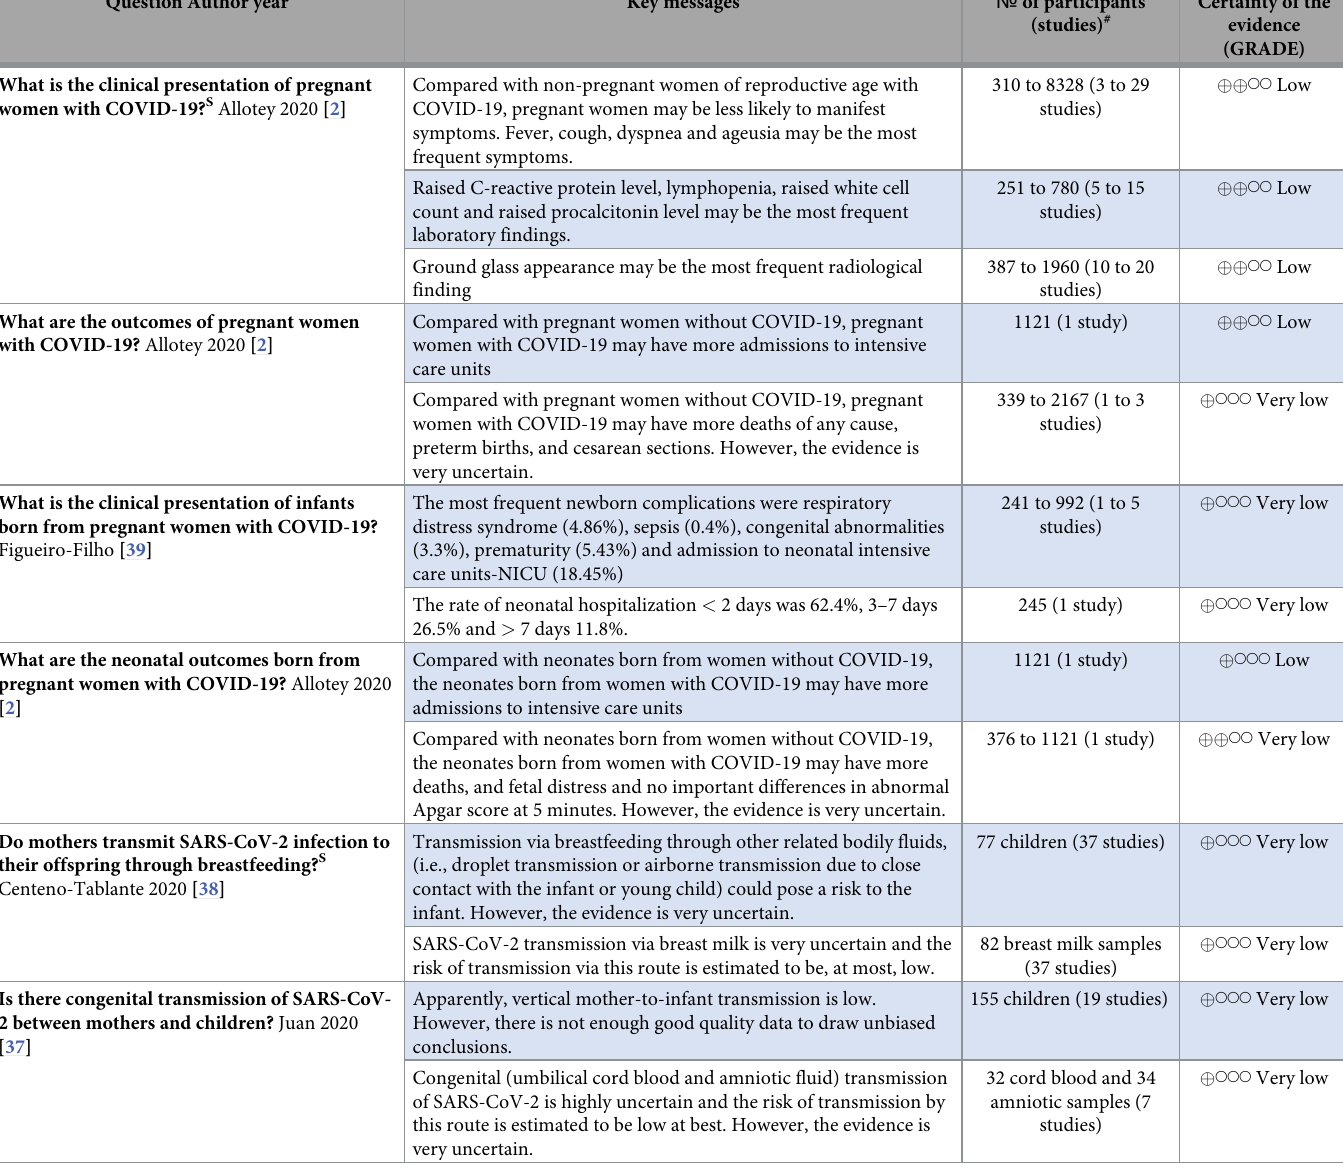
Table 3. Key messages of prioritized systematic